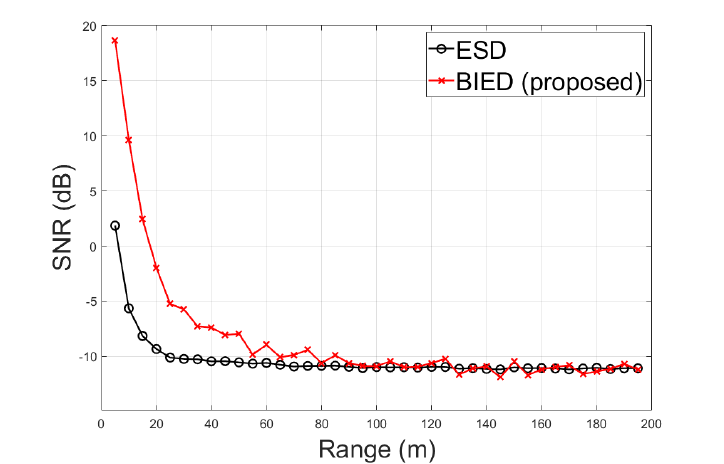
Figure 11. SNR of pre-processed signals in the ESD method and the BIED method.